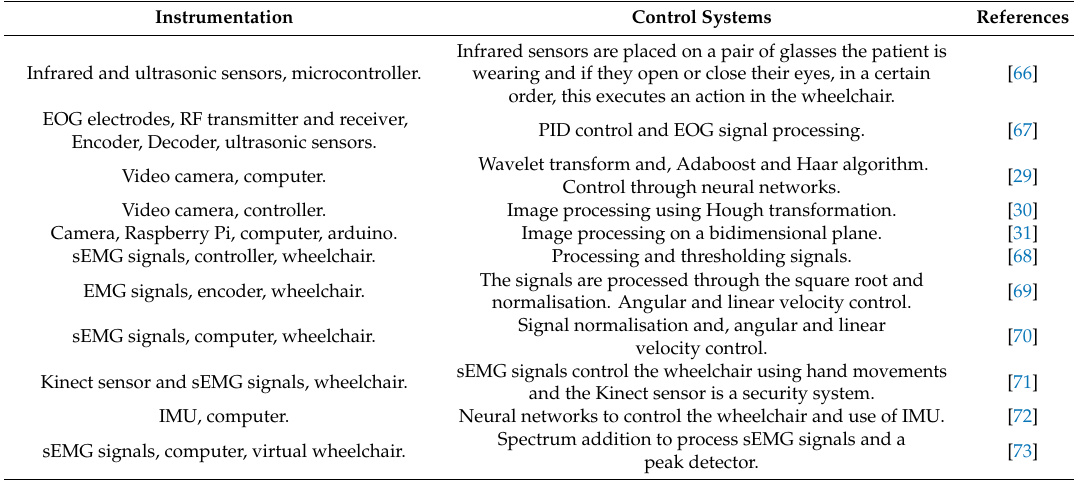
Table 6. Instrumentation and control strategies implemented for signals or body